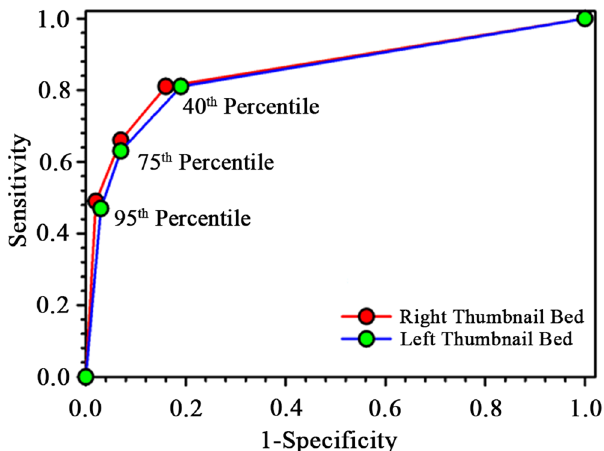
Figure 4. Receiver operating characteristics (ROC) curves for AJO-Neo bilirubin value collected from the left and right nailbed. The cut-off values were 95th, 75th, and 40th percentile of Bhutani nomogram for phototherapy in neonatal hyperbilirubinemia.